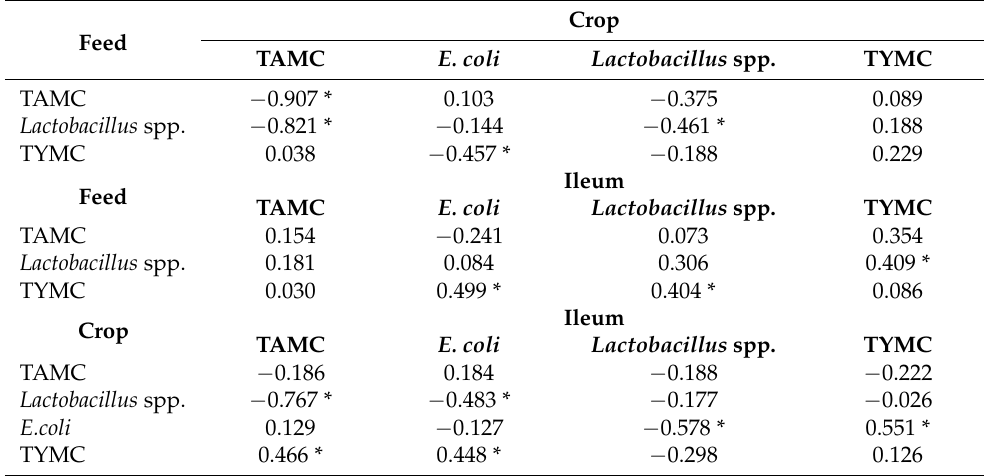
Table 7. Correlation between count of microorganisms ( n = 27). Feed